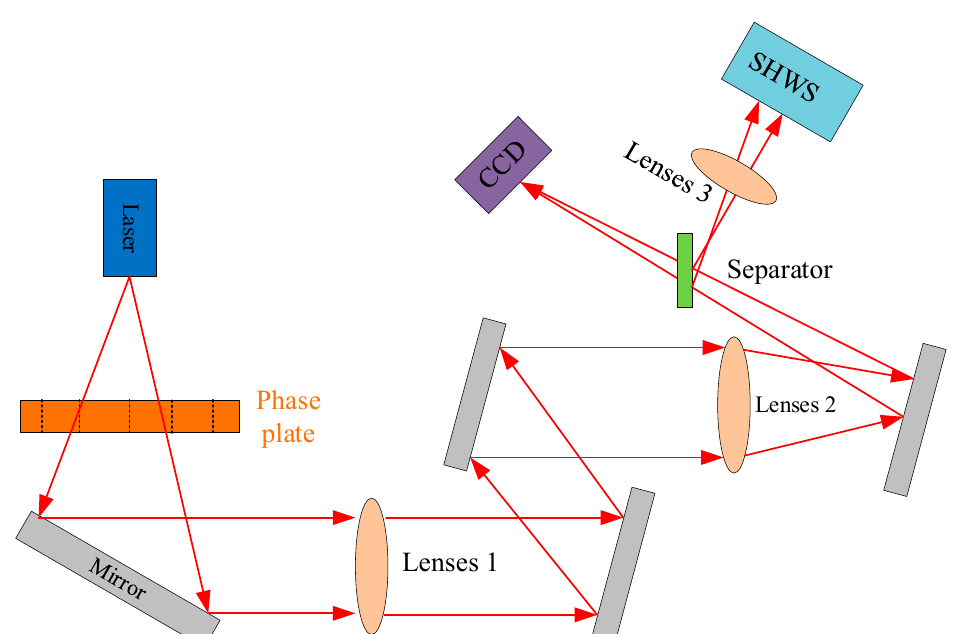
Figure 5. Schematic sketch of the wavefront phase structure function method.